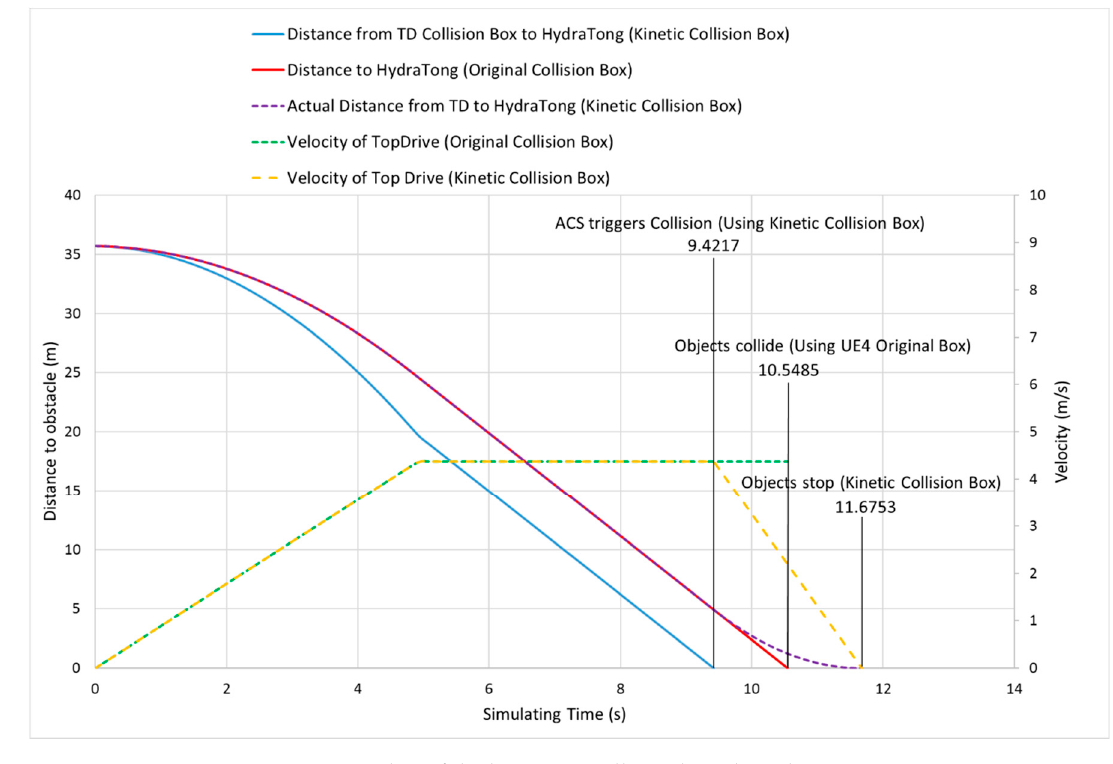
Figure 12. Functionality of the kinematic collision box algorithm in Scenario 1.